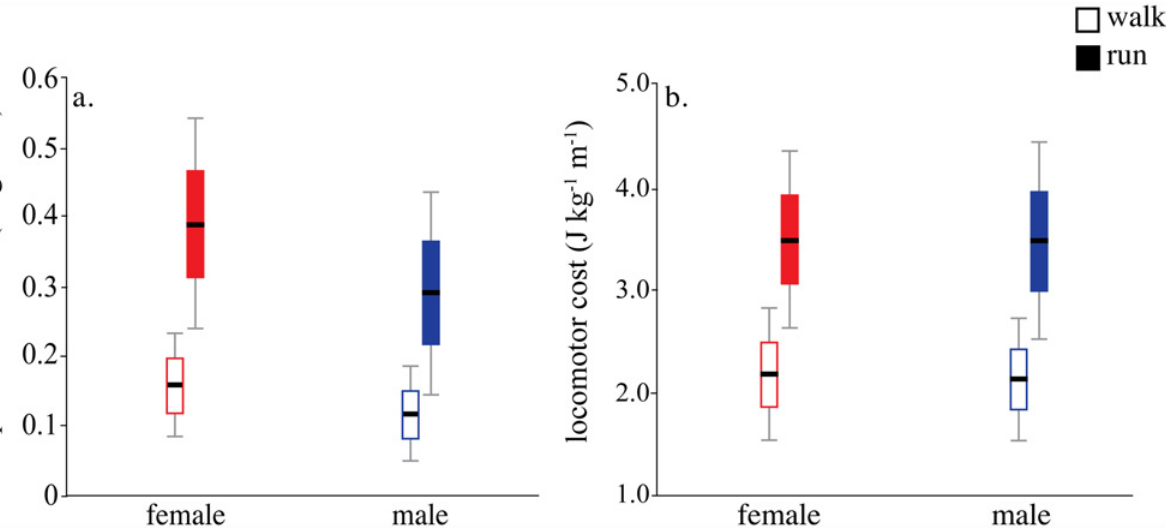
Fig 3. Metabolic cost of hip abductor activation and net locomotor cost in men and women. a. Hip abductor mass-specific cost is higher in women at both a walk ( P = 0.006) and a run ( P = 0.006) due to lower EMA from shorter average abductor moment arm length (see text, Table 2) b. Net mass-specific locomotor cost does not differ between men and women at a walk or a run. Black bar indicates mean, box indicates mean ± 1SD and whiskers are mean ± 2SD.